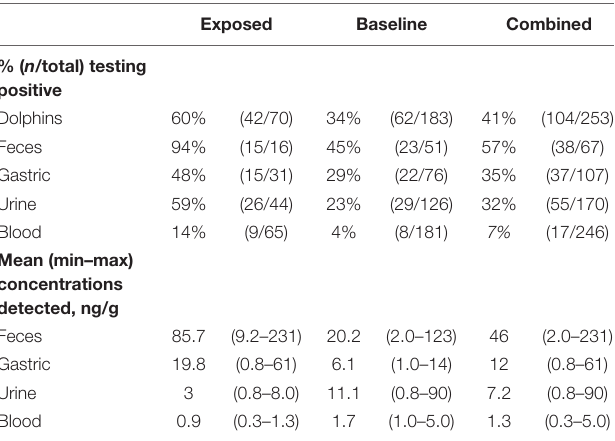
TABLE 1 | Proportions of PbTx-positive dolphins and sample types by exposure category, and PbTx concentrations detected.